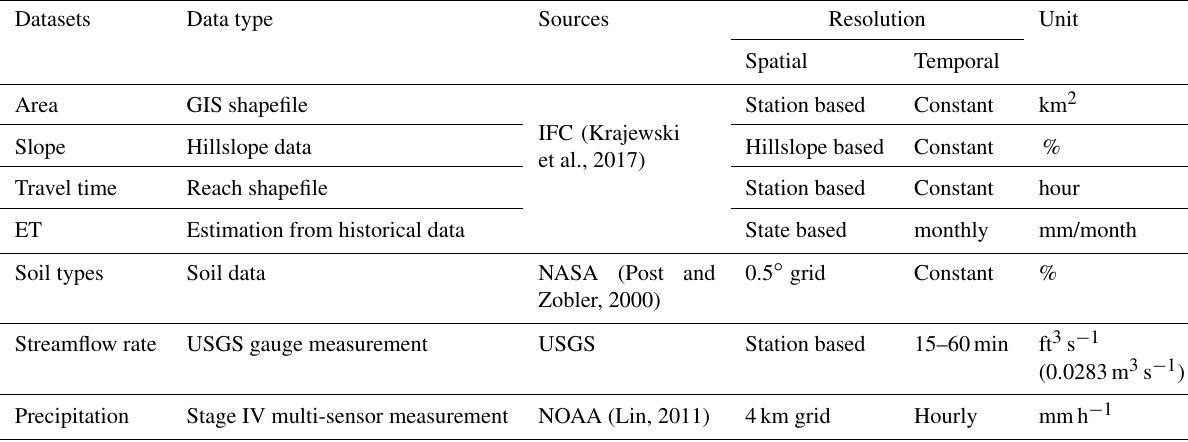
Table 1. The details of datasets with data source, type, resolution and units. Datasets